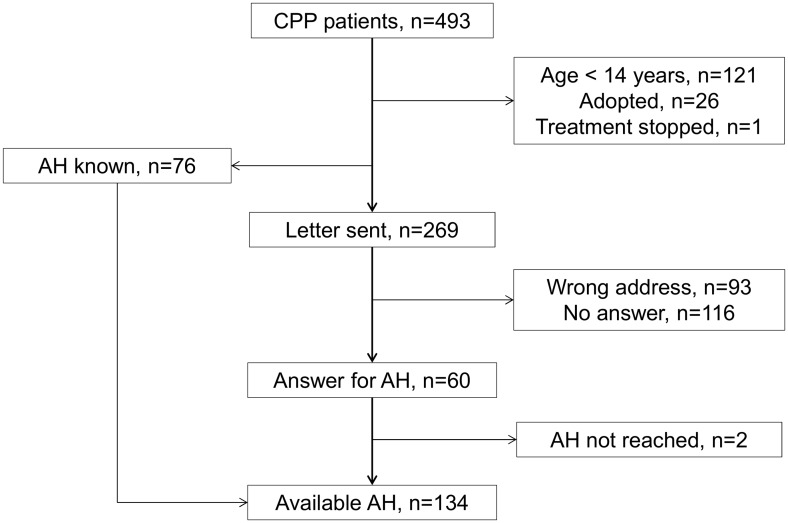
Flow chart of the inclusions of girls with CPP.